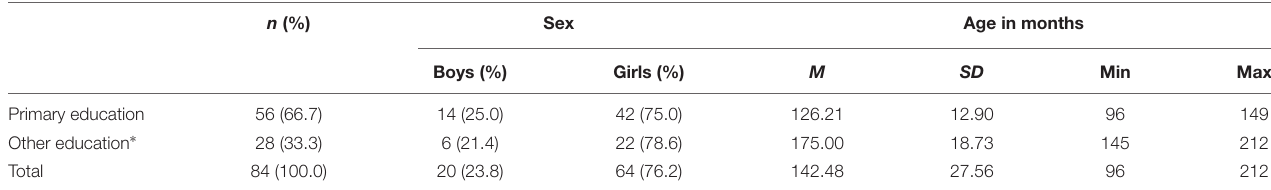
TABLE 1 | Participant data for total group by education